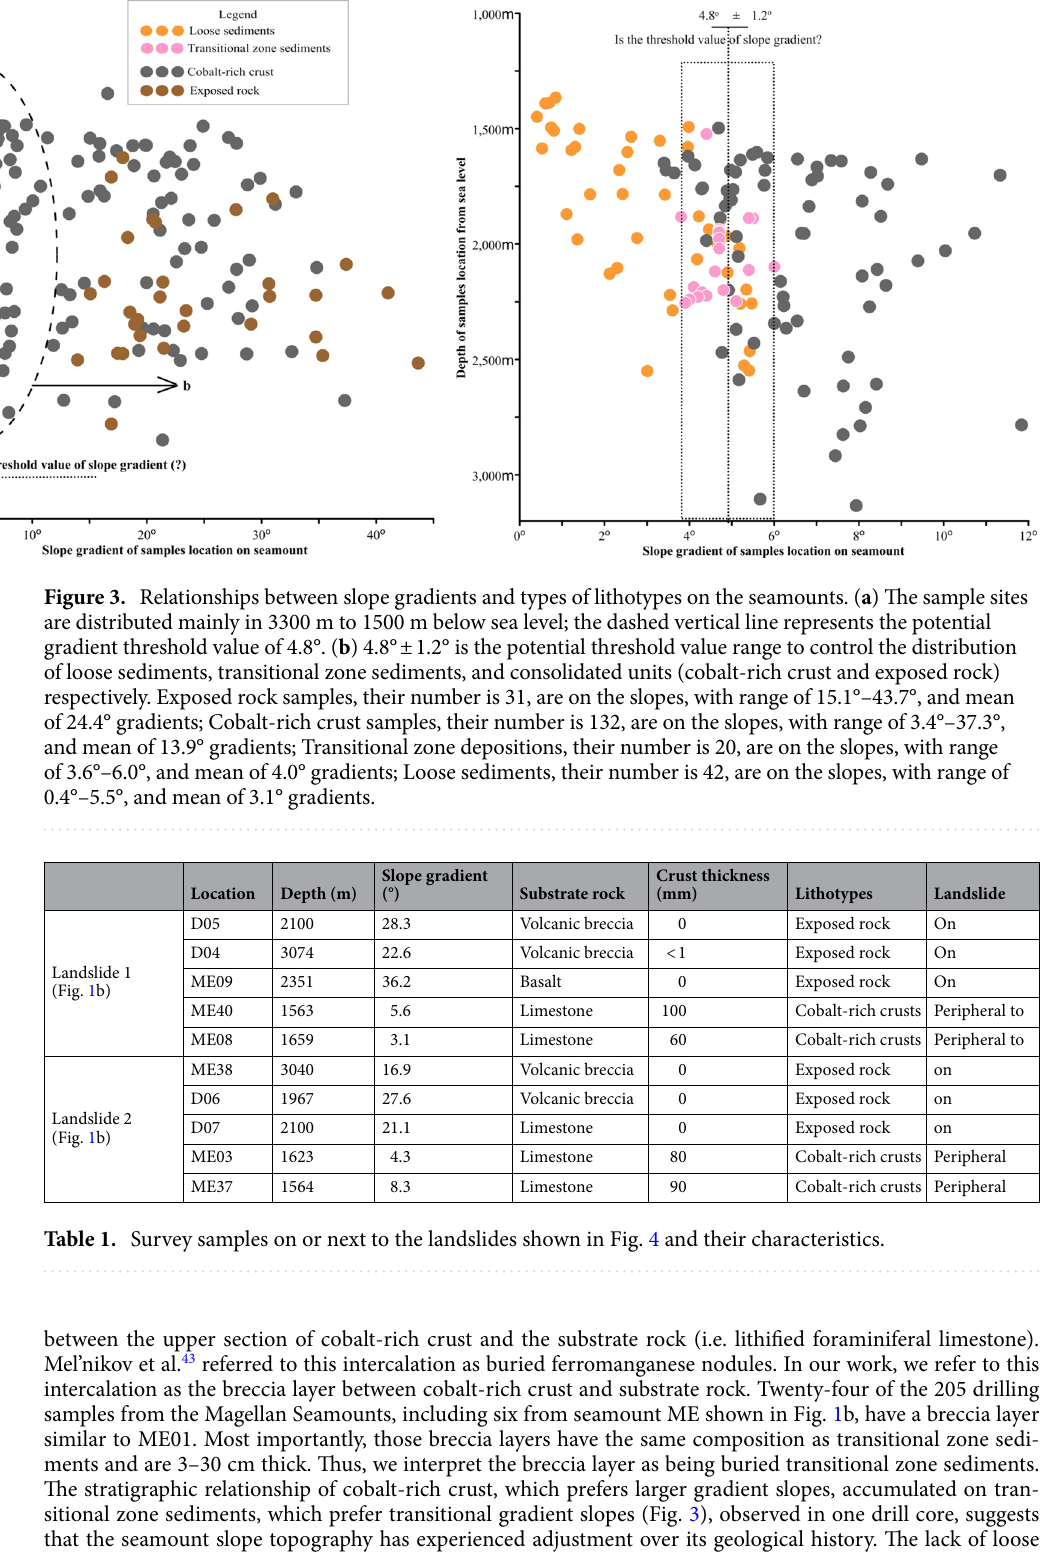
during the slope adjustment that resulted in the stratigraphic formation of cobalt-rich crust and transitional zone sediments. Stratigraphic chronology and records of slope changes in cobalt-rich crusts. There are layered structures in the cobalt-rich crust sections, e.g. layers III, II, I2 and I1 in Fig. 4c–e. Each layer has distinct